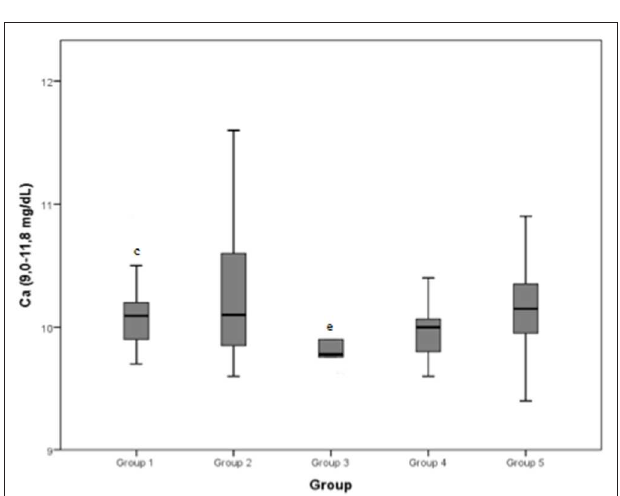
FIGURE 7 | Calcium (Ca) (normal range: 9.0–11.8 mg/dL) differences between the five examined groups. Statistically significant differences are indicated as follows: (c) significantly different from group 3; (e) significantly different from group 1.